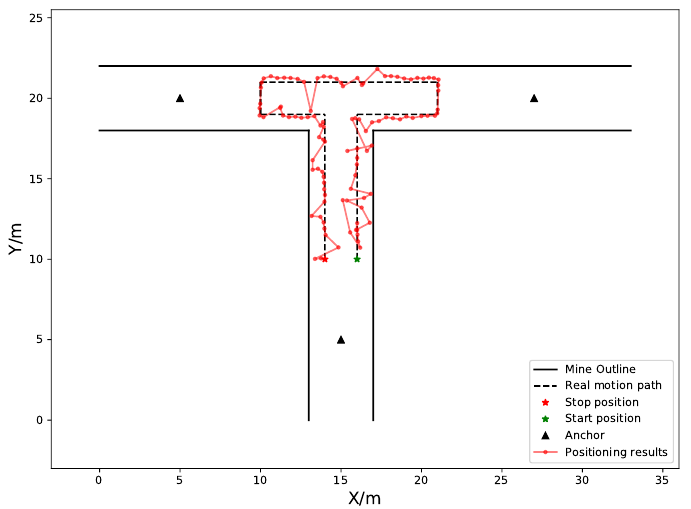
Figure 18. The dynamic tracking